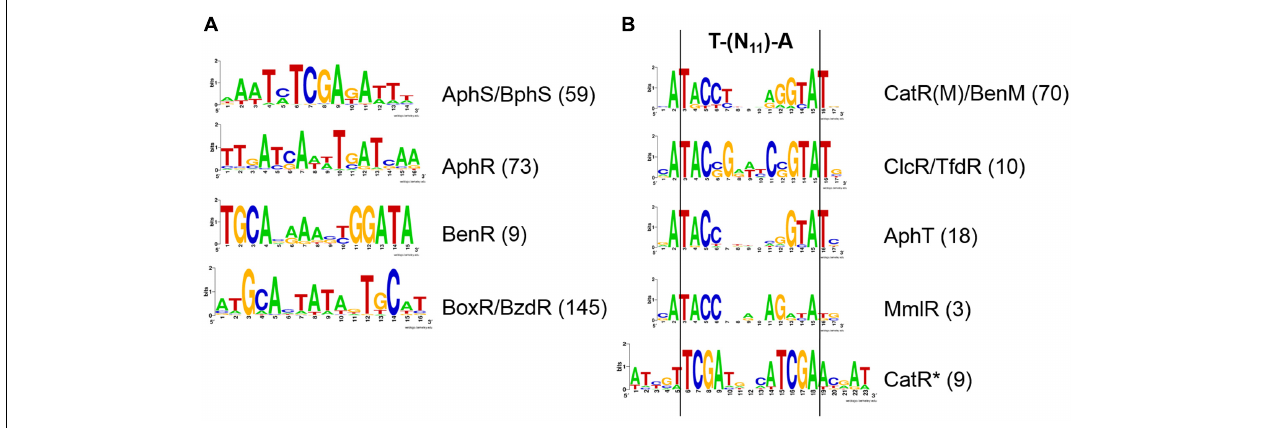
FIGURE 2 | LOGO diagrams of transcription factor binding motifs. (A) AphS/BphS, AphR, BenR, and BoxR/BzdR. (B) LysR-family regulators of the aromatic metabolism. The LOGO diagrams were built using all the predicted binding sites for the respective TF in all studied genomes (see Supplementary Table S3 ), the exact numbers of sites are given in parentheses.